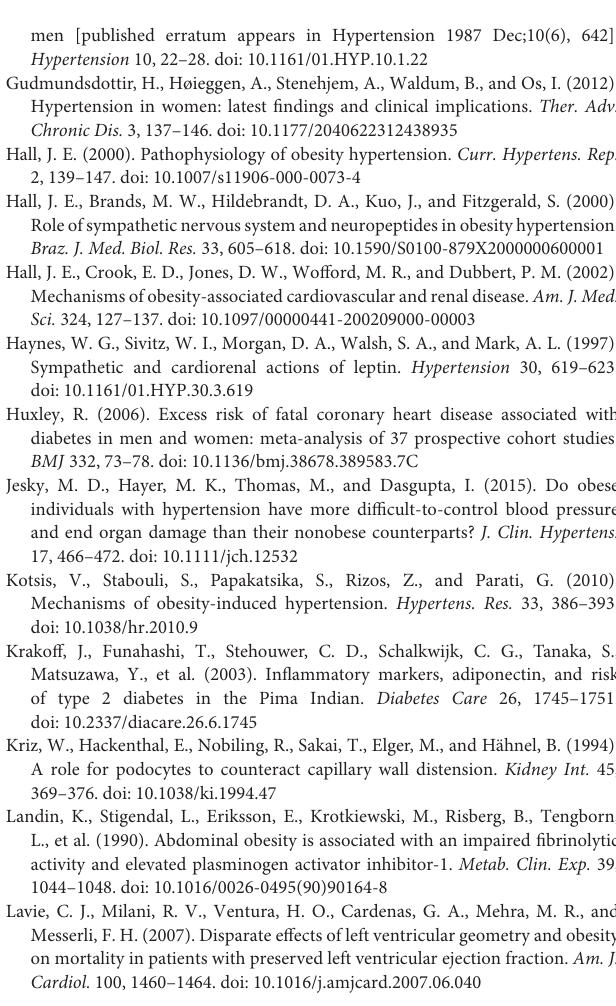
Supplementary Table 1 | Table represents sensitivity analysis for calculating interaction between waist circumference and blood pressure (BP) systolic and diastolic as independent factors with continuous traits on adipokine